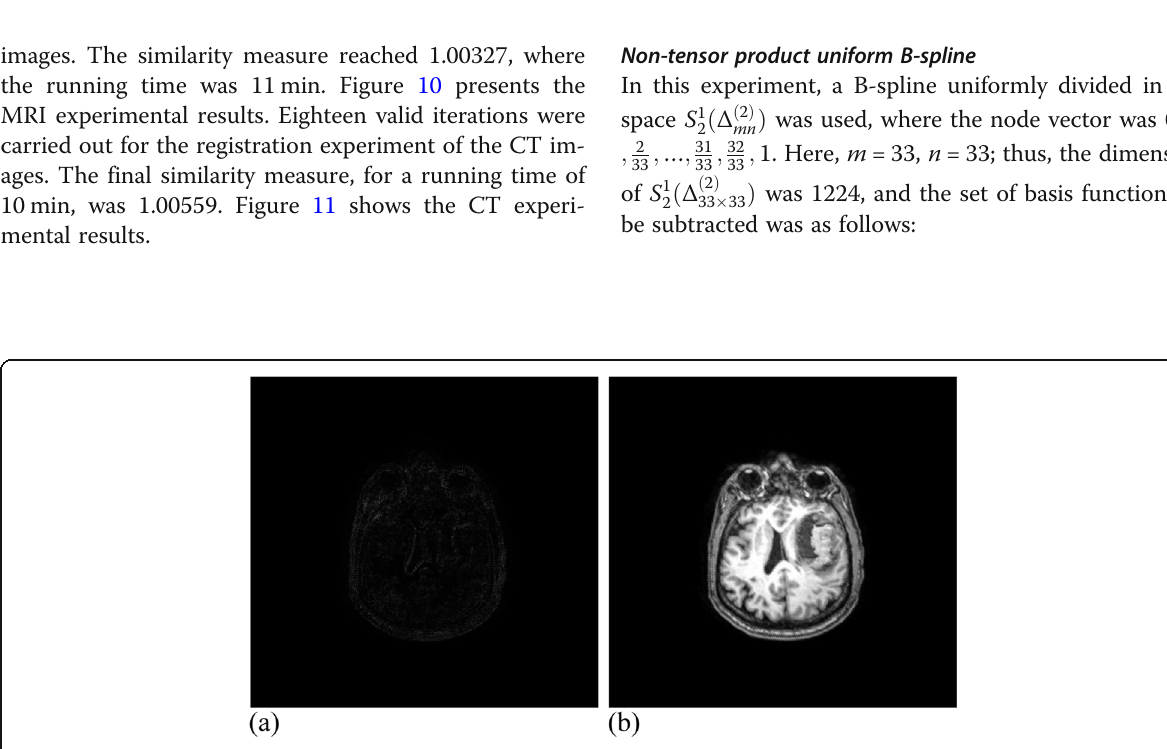
Fig. 8 MRI data after registration. ( a ): Difference between MRI reference image and registration image; ( b ): MRI registration